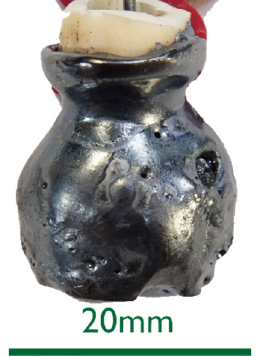
Figure 4. Macroscopic photograph of the sample C750-ULC-3.